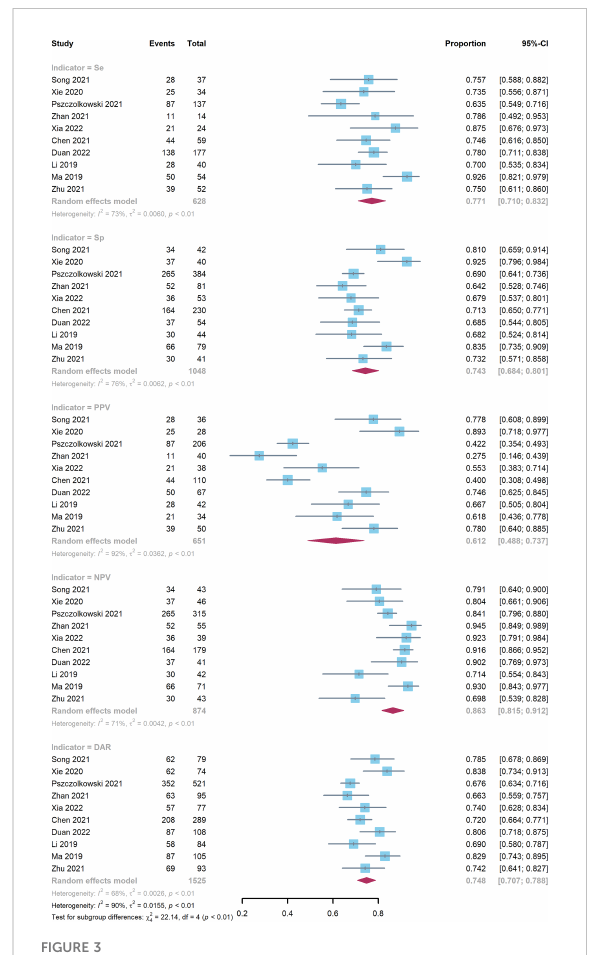
FIGURE 3 Forest plot of radiomics model. CIs: con fi dence intervals; DAR: diagnostic accuracy rate; NPV: negative predictive value; PPV: positive predictive value; Se: sensitivity; Sp: speci fi